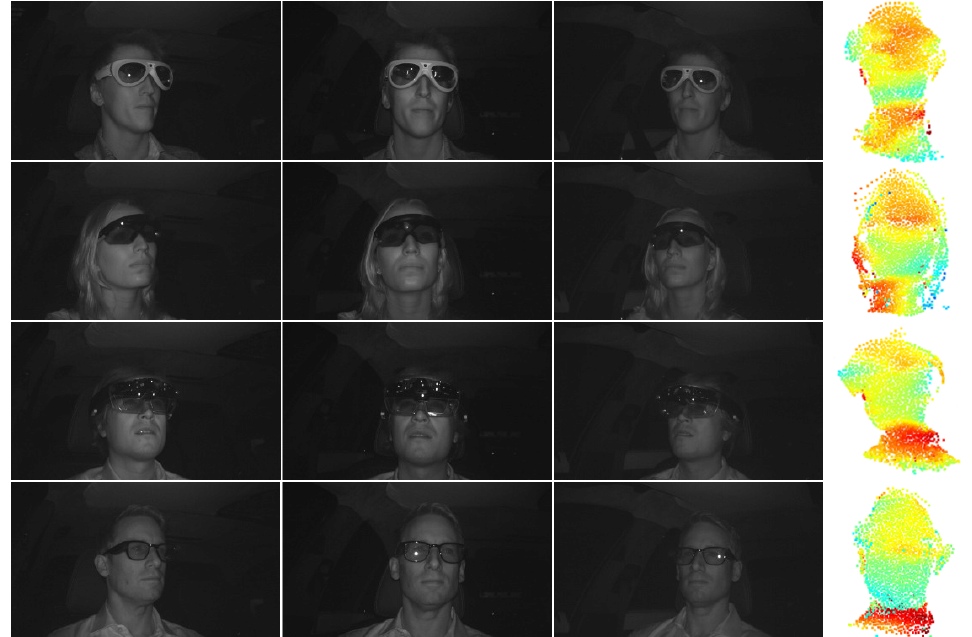
Figure 6. Four example triples with the estimated point cloud, predicted by the central image only. Each row visualizes an example triple for a different person, wearing different glasses and the corresponding point cloud. The lighter the blue color of 3D point, the more the relative distance of a particular 3D